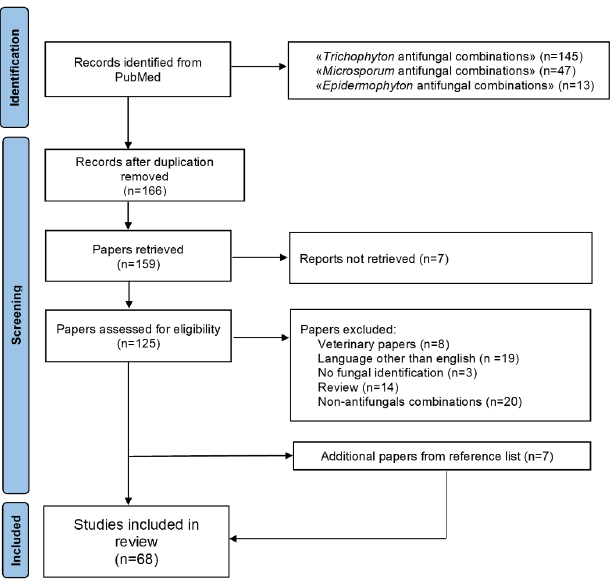
Figure 1. Flowchart of the different phases of article selection of the review.